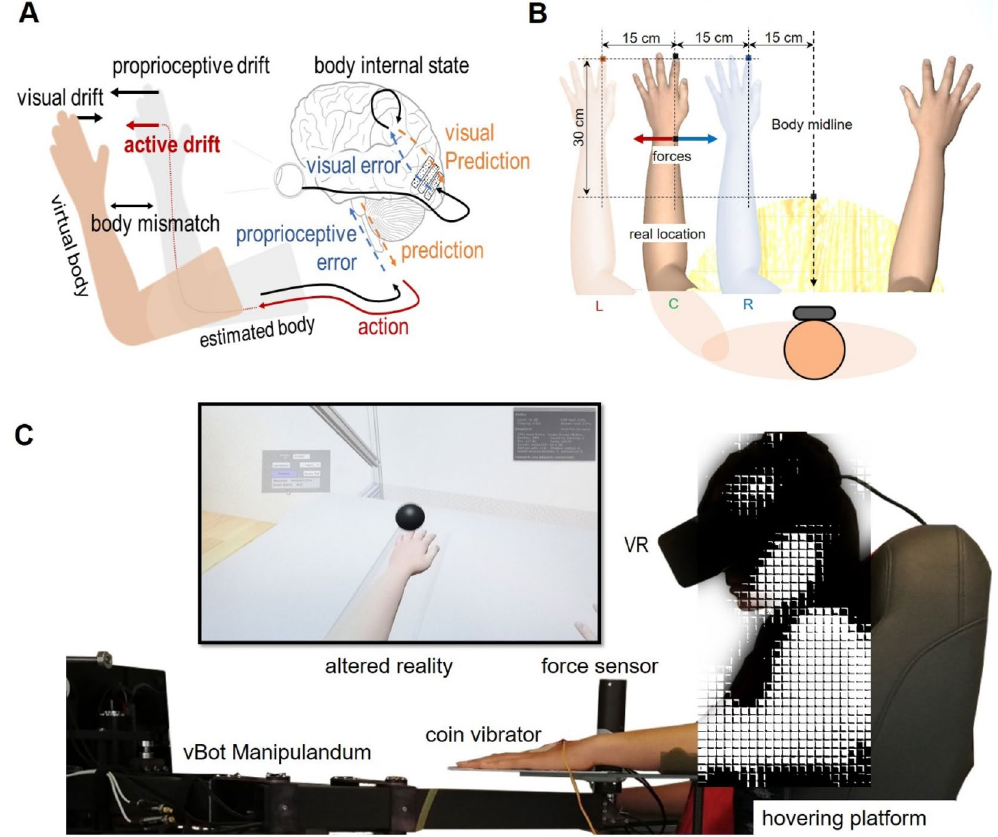
Figure 1. Predictive brain approach and VHI experimental setup. ( A ) Schematic of the perceptual drifts (visual, proprioceptive) and the active component, and its relation to prediction minimization. Both the proprioceptive and visual drifts are produced by the same process of body estimation under visuo-proprioceptive mismatch and the active drift (forces towards the virtual hand) is a consequence of proprioception error minimization through the reflex arc pathway. ( B ) VHI conditions. At each trial the virtual hand was placed in one of the three different locations: Left (− 15 cm), Center (0 cm) and Right (+ 15 cm) with respect to the real hand location, i.e., the center corresponds to the real hand position. The real hand was placed 30 cm away from the body midline. ( C ) The perceptual stimulation was performed using immersive VR and a coin vibrator for the tactile stimulation. Lateral force measurements were recorded using a 6DOF force-torque sensor on the robotic manipulandum